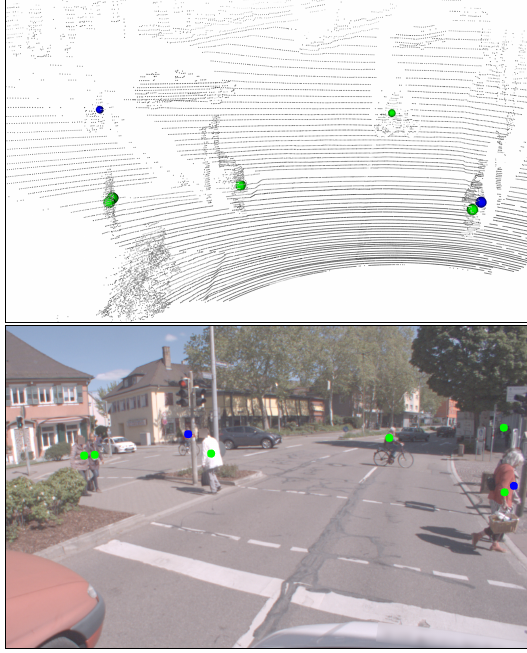
Figure 4. Top: Visualization of an exemplary output of our approach: detected persons are marked by green dots. Currently undetected but tracked persons are predicted by a blue dot. Bottom: The same scene shown in a synchronously recorded video, with all 3D markings projected to the